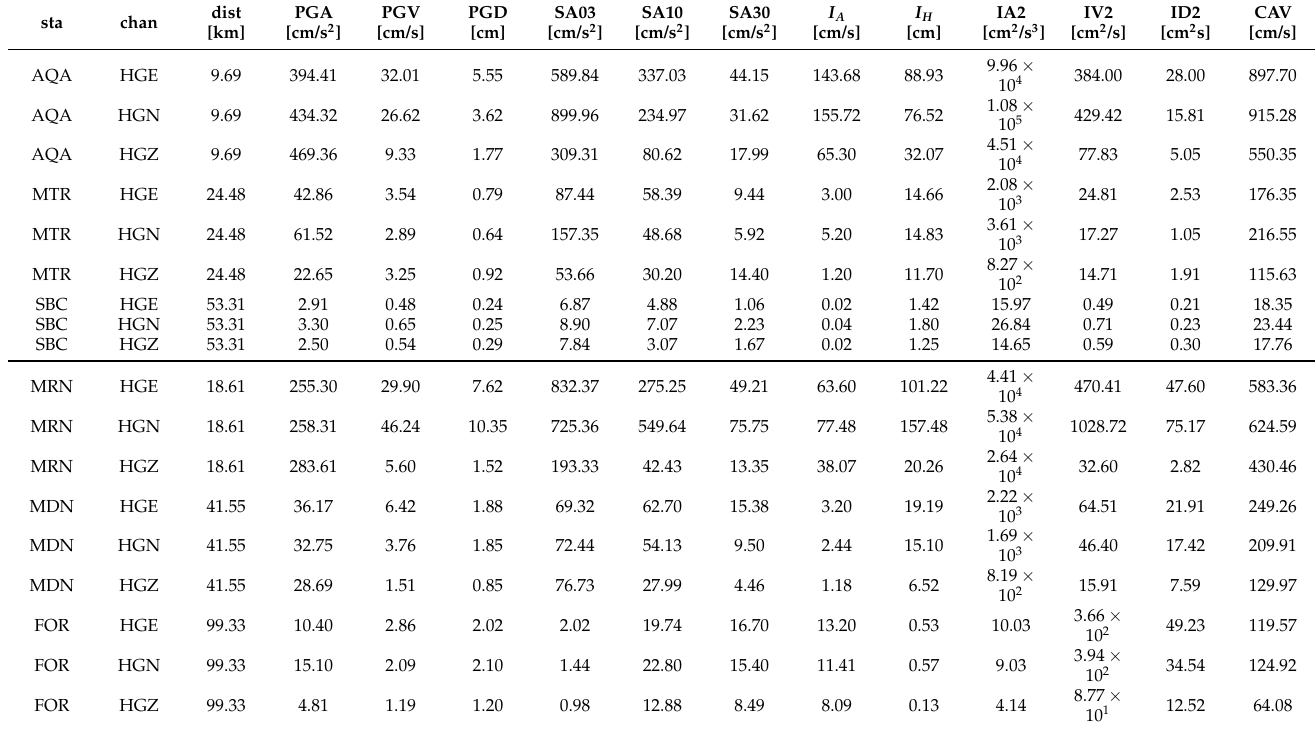
Table 1. Examples of the ground motion parameter tables contained in the near real-time reports for two different events. In the upper part of the table, the parameters for the 6 April 2009 L’Aquila (Italy, Lat 42.342, Long 13.38) earthquake ( M l 5.6 ) are reported. In the lower part of the table, the parameters for the 20 May 2012 Emilia (Italy, Lat 44.896, Long 11.264) earthquake ( M l 6.0 )